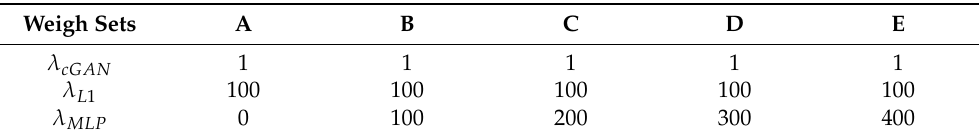
Table 2. Different sets of weights used to evaluate the original pix2pix and the pix2pix cGAN with the MLP loss function.